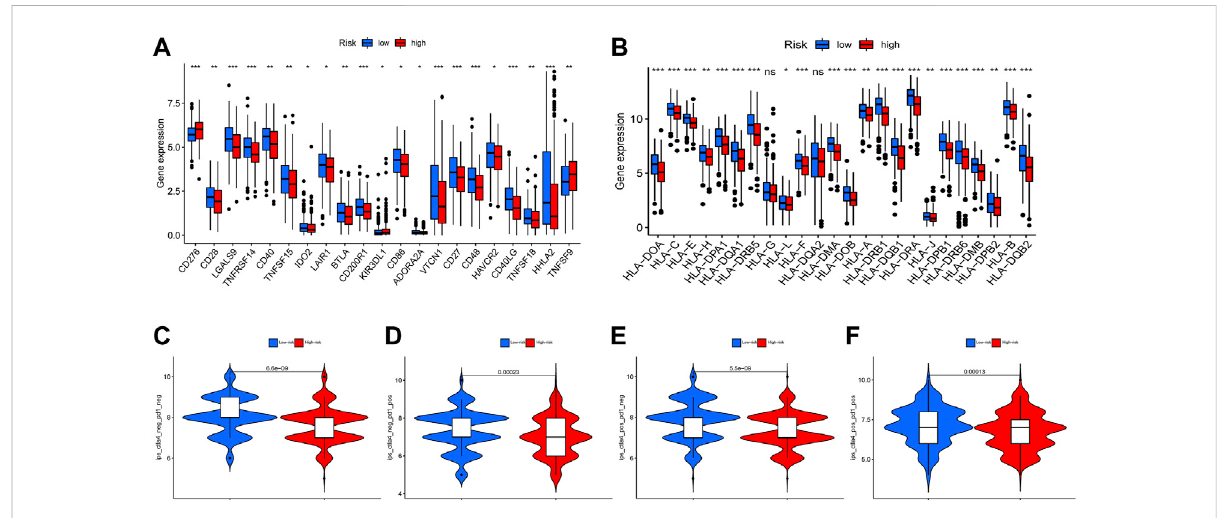
FIGURE 8 The correlations between risk score and immune checkpoint, immunephenoscores (IPS). The difference of immune checkpoint related genes (A) a and HLA-related genes (B) were showed in boxplot between high-risk and low-risk groups. The differences of IPS in patients with different risk are shown (C – F) (ns, not signi fi cant, * p < 0.05, ** p < 0.01, *** p <